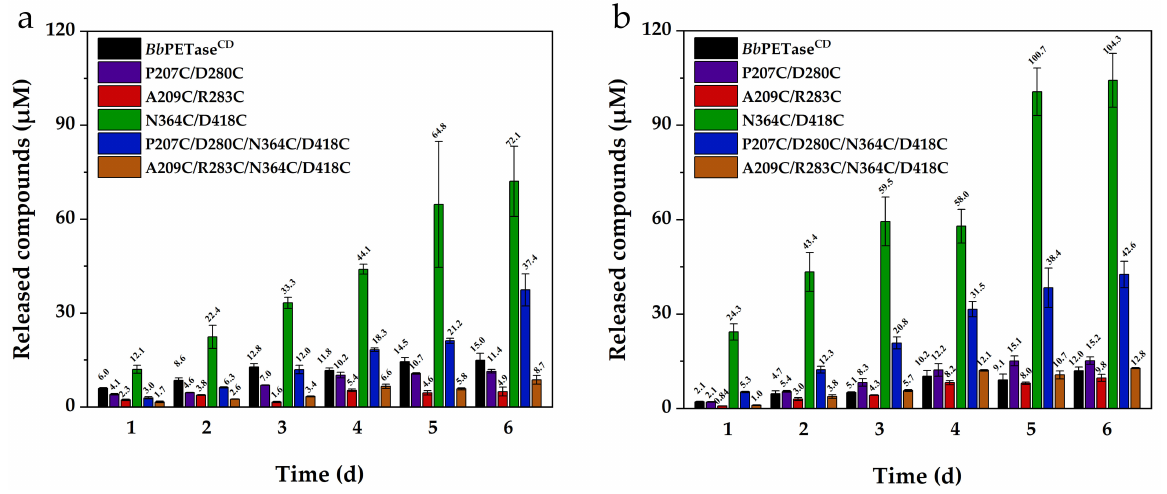
Figure 3. Hydrolytic activity of Bb PETase CD and its variants on PET fi lms at 30 °C ( a ) and 40 °C ( b ). The final concentration of the enzyme was 200 nM. Two PET films of 6 mm diameter were placed in each centrifuge tube as substrates.